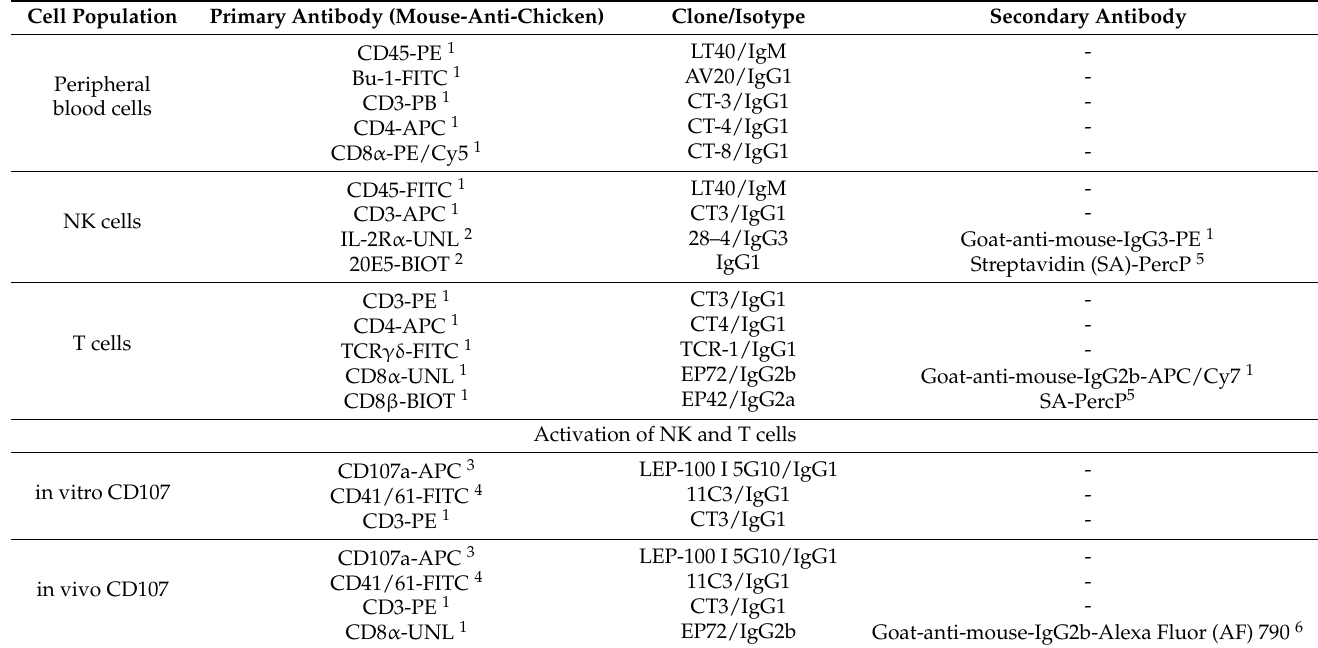
Table 1. Flow cytometry staining